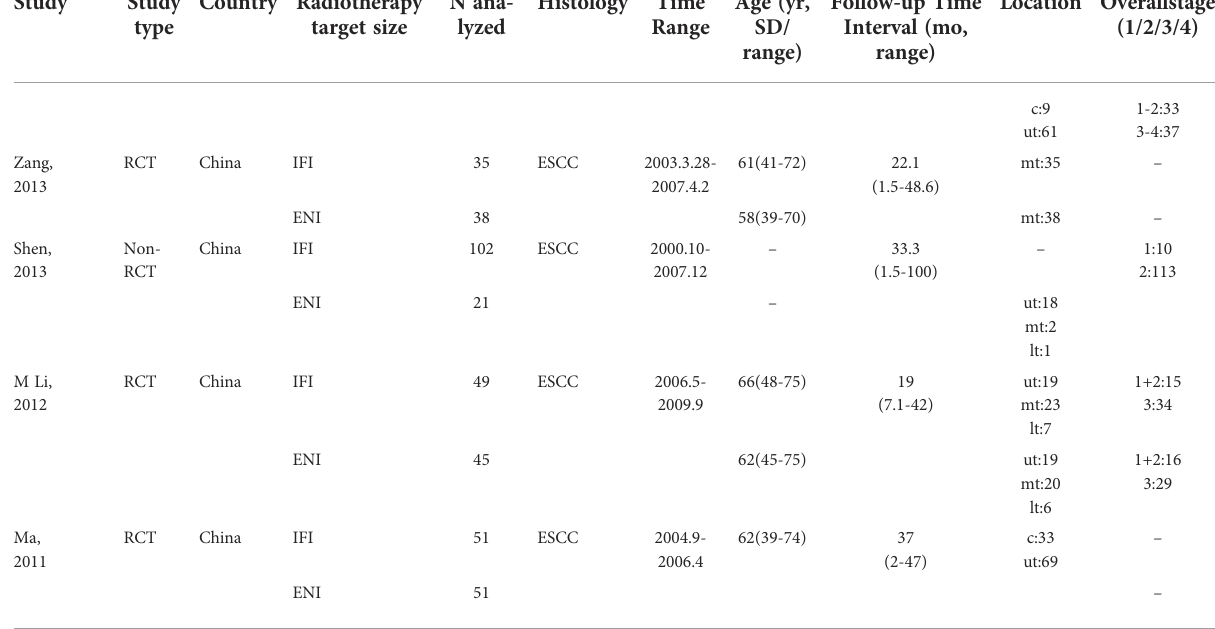
Figure 5B for non-RCTs group), the type of radiotherapy (Supplementary Figure 6A for the 3D-CRT group, Supplementary Figure 6B for IMRT group, and Supplementary Figure 6C for 3D-IMRT – mixed group), the type of pathology (Supplementary Figure 7A for the ESCC group, and Supplementary Figure 7B for ESCC-mixed group), and the type of chemotherapy received (Supplementary Figure 8A for the CCRT group, Supplementary Figure 8B for CCRT+CT group, and Supplementary Figure 8C for CRT-mixed